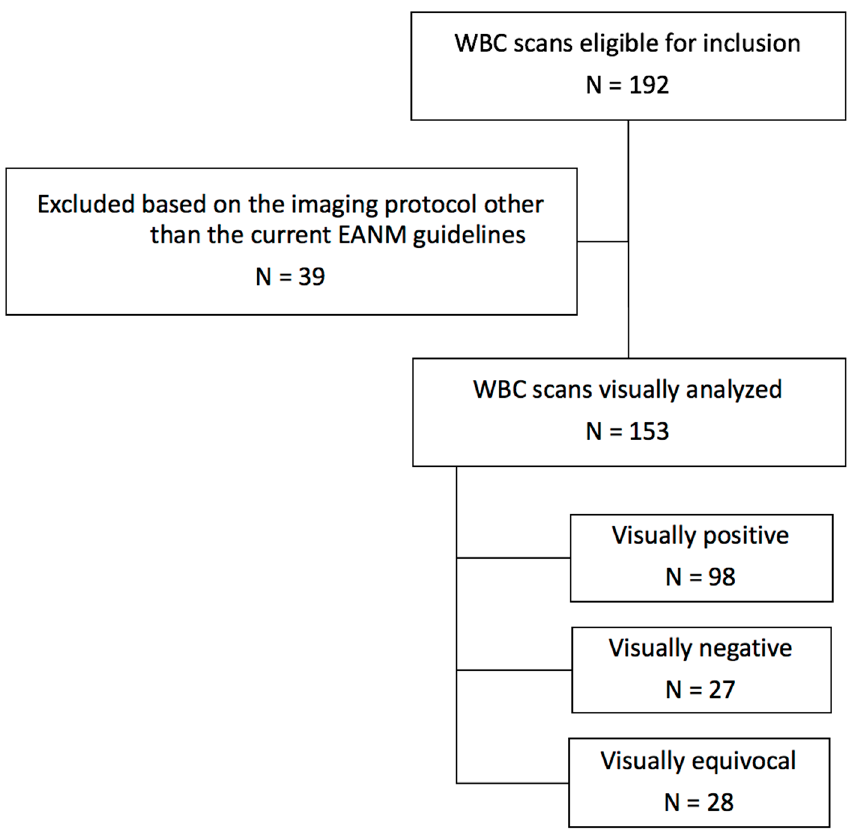
Figure 2. Flowchart of patient inclusion .